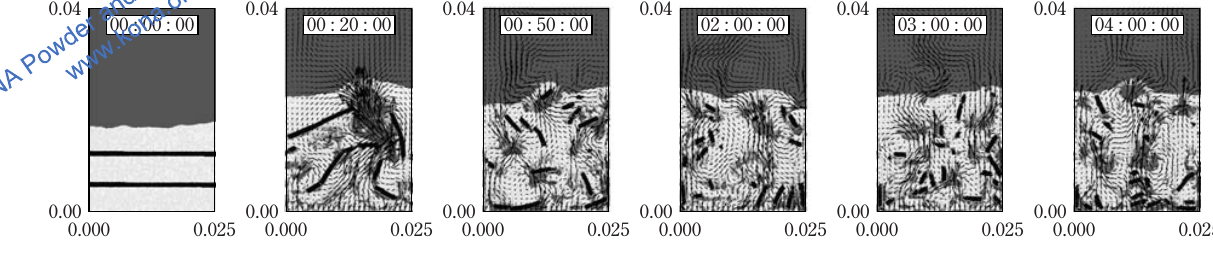
Fig. 4 The gas-solid flow patterns with an initial two layers of 5,000 cohesive (black) particles placed alternatively in the bed of 40,000 cohe- sionless (white) particles at u/u mf (cid:1) 4.8. The ratio of the maximum cohesive force at z min to particle weight